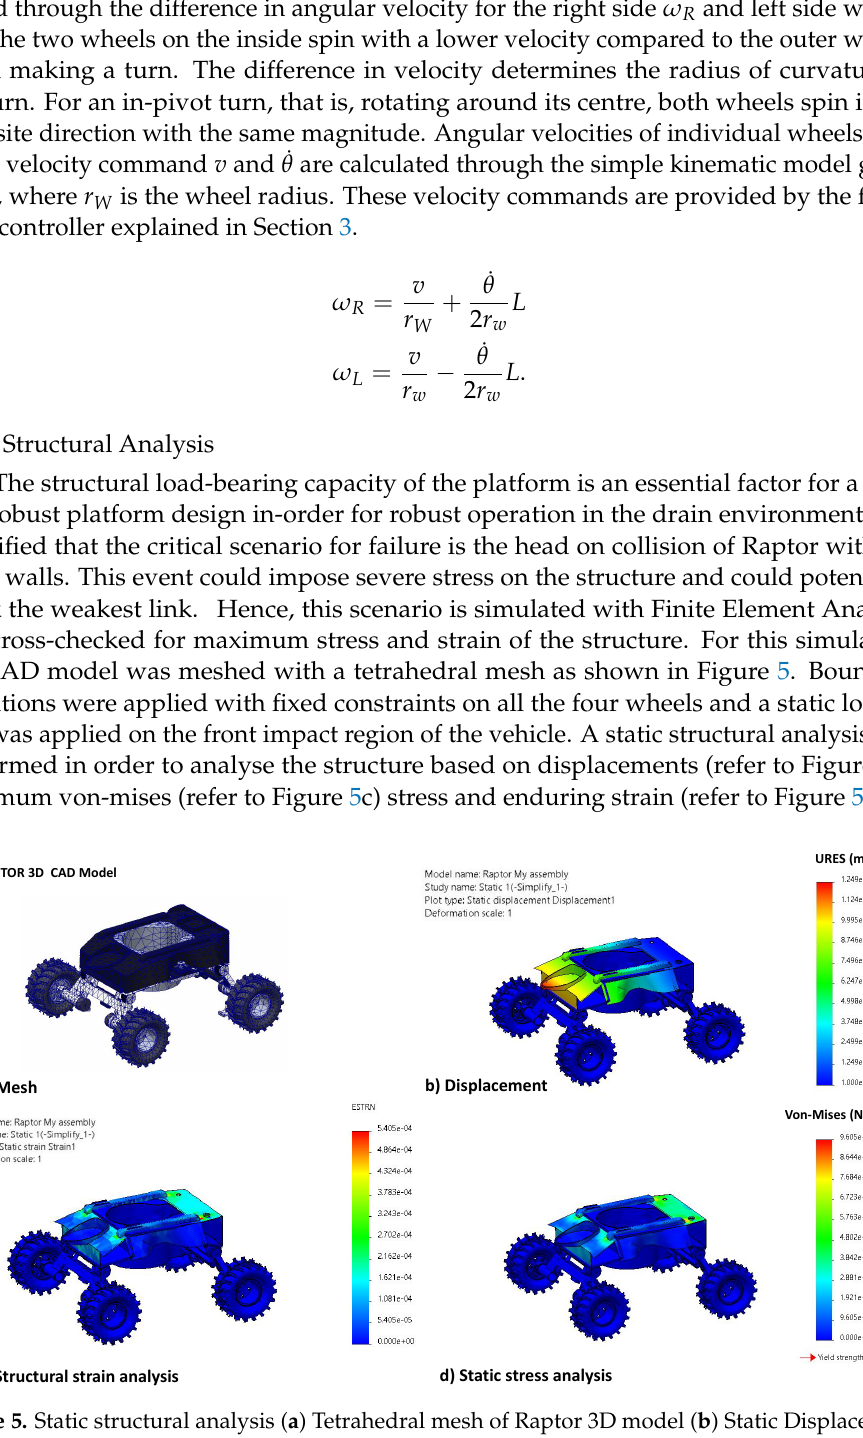
Figure 5. Static structural analysis ( a ) Tetrahedral mesh of Raptor 3D model ( b ) Static Displacement analysis ( c ) Strain Analysis results ( d ) Von Mises stress in N/m 2